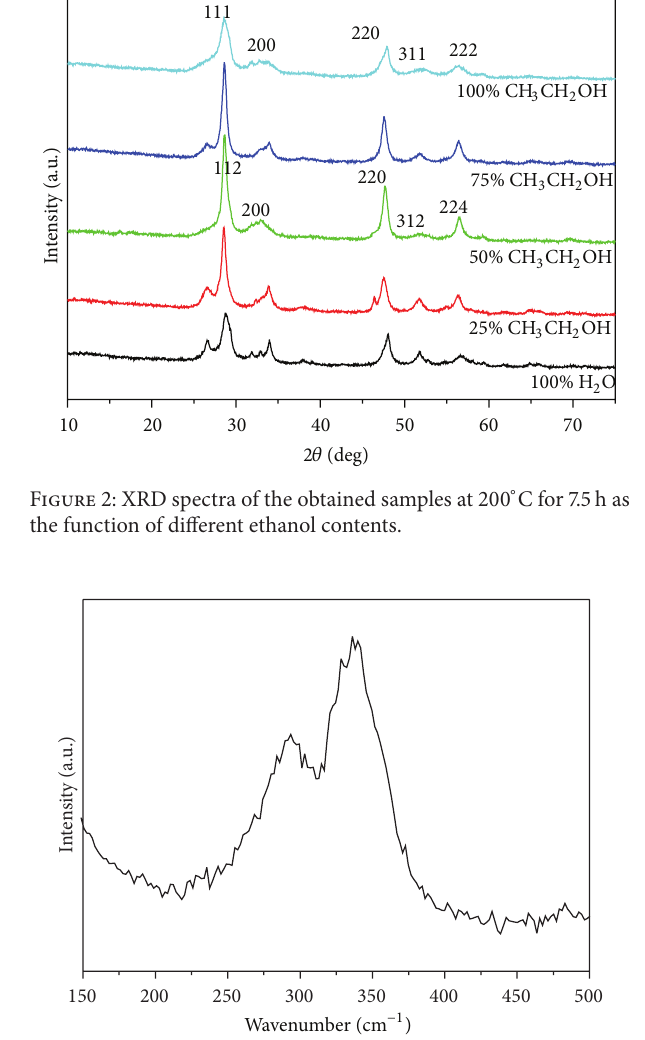
Figure3:Ramanspectrumoftheobtainedsamplesat200 ∘ Cfor7.5h with 50vol%